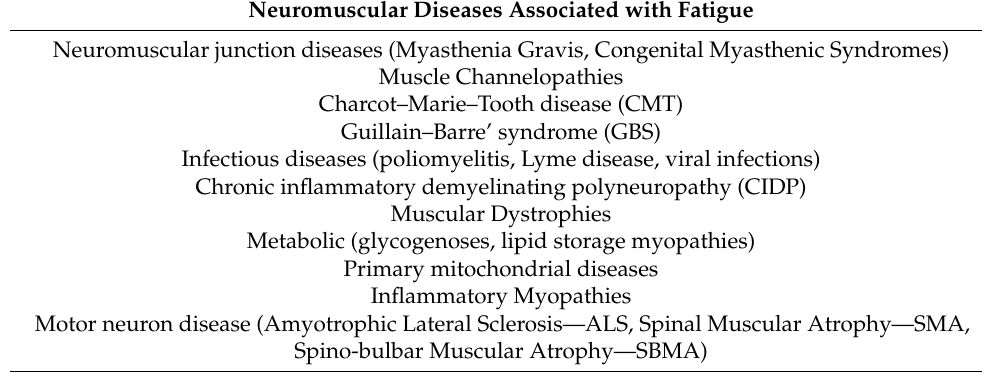
Table 1. Neuromuscular diseases associated with